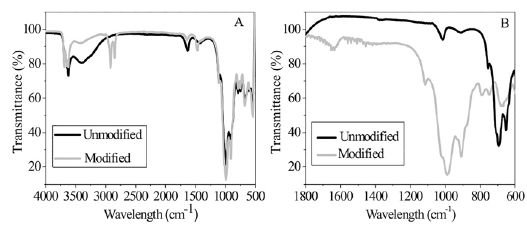
Figure 1. Details of welded joint geometry. Dimensions in